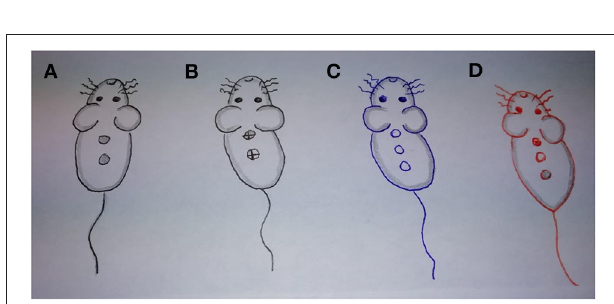
FIGURE 2 | Sampling of murine wounds (handmade) for comparisons. (A) . Infected wounds treated with MB-aPDT. (B) Infected wounds treated with MU (dorsally combined with aPDT and ventrally in solitary). (C) Control (untreated) Infected wounds. (D) Healthy skin (dorsally ulcer by abrasion, in the middle intact skin, ventrally intact skin with